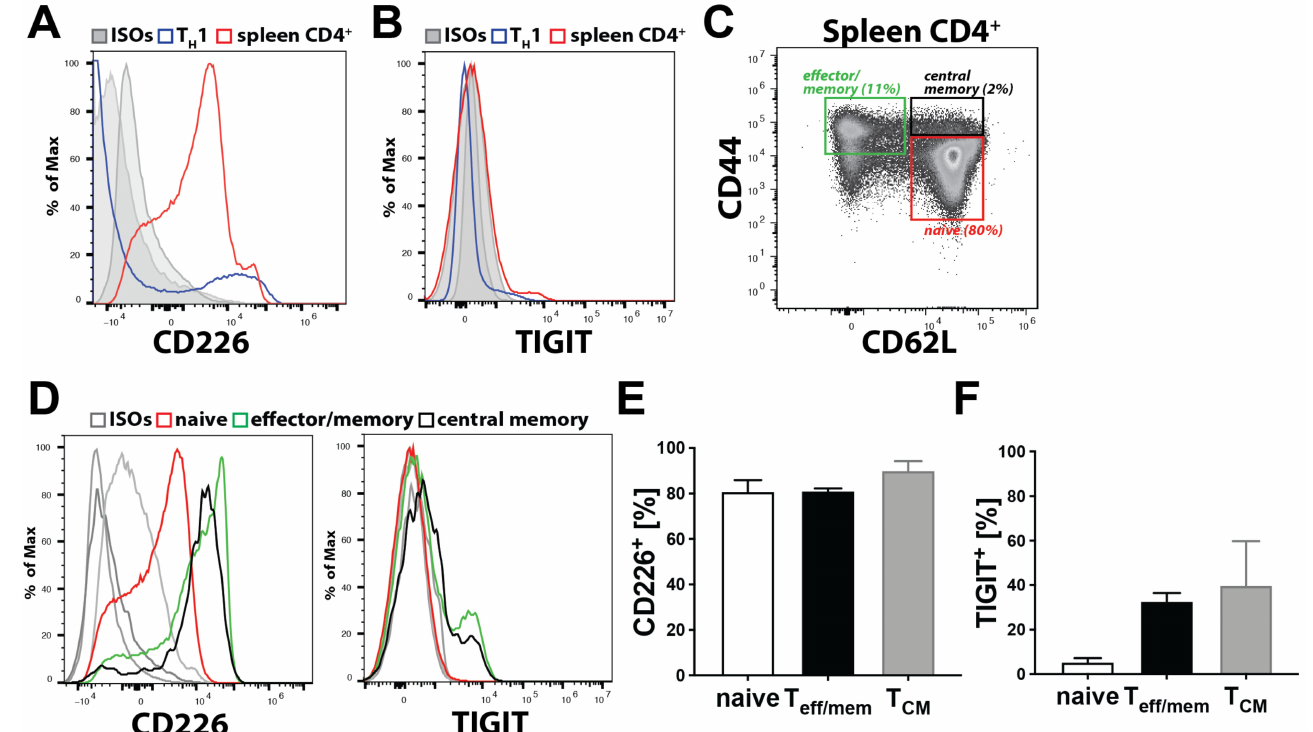
Figure 5. CD4 + T cells express CD226. ( A – F ) Analysis of CD112 binding partner expression on T cells. CD226 ( A ) and T cell immunoreceptor Ig tyrosine (TIGIT) ( B ) expressions on freshly isolated splenic CD4 + T cells (red) and in vitro generated T H 1 cells (blue). ( C ) Characterisation of naïve, effector/memory and central memory T cells based on CD44 and CD62L expressions of splenic CD4 + T cells. ( D ) CD226 (left) and TIGIT (right) expression on naïve (red), effector/memory (green) and central memory (black) T cells. Representative graphs from one out of three similar experiments are shown. ( E , F ) Percentages of CD226 + ( E ) or TIGIT + ( F ) T cells. T eff/mem : effector/memory; Table 3 . 5. CD112 Deficiency Reduces Homing of T Cells to the